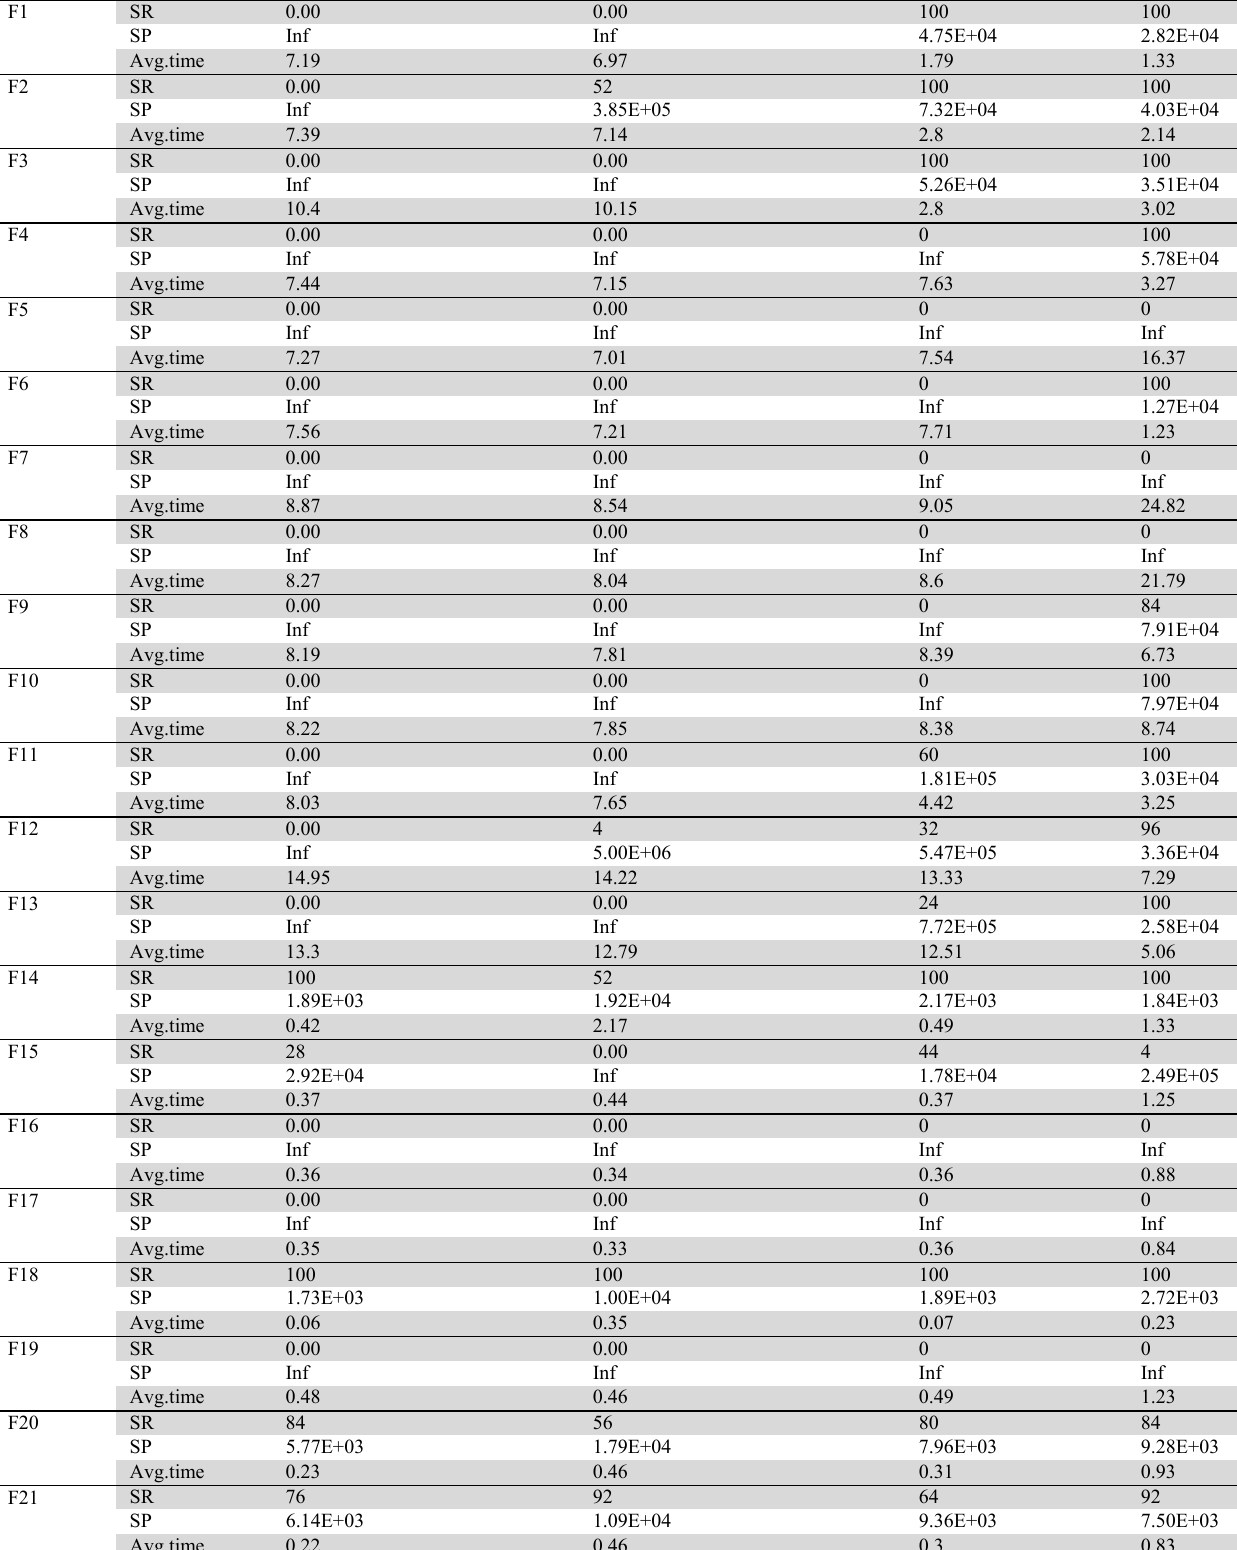
Comparative SR, SP and Average time of 21 benchmark function with other DE mutation strategies. Function DE/target to best/1/bin DE/Current to